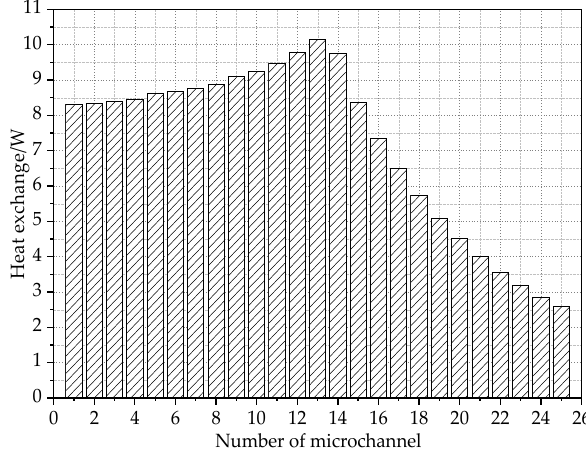
Figure 19. Heat transfer rate of the microchannels.